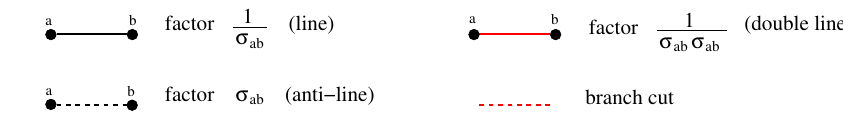
Figure 1 . Vertex Color code in CHY-graphs for the (cid:3)-algorithm.